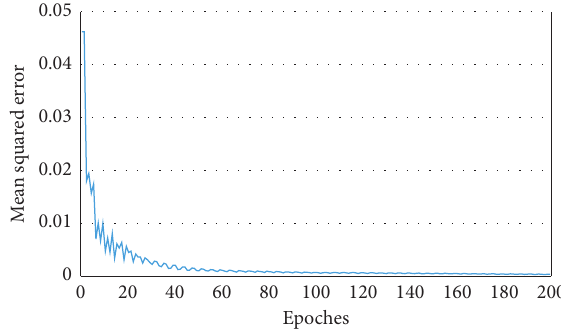
Figure 6: Changes in MSE during training